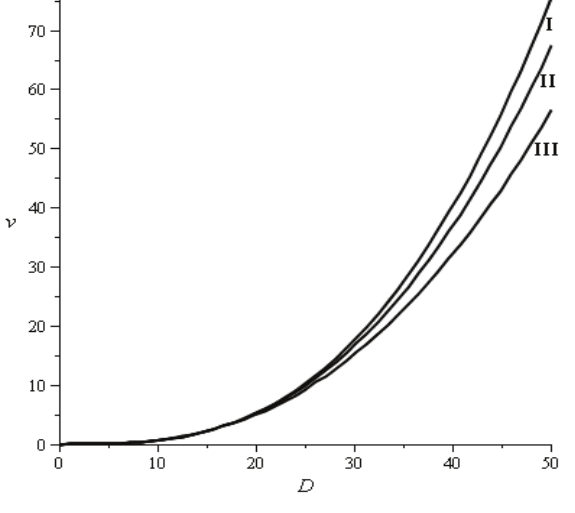
Figure 2. Stumpage price models: Quality I, v = D 3.186471 exp( (cid:28)202 (cid:14)34(cid:15)(cid:4)(cid:28)(cid:4)(cid:31)0(cid:26)2(cid:31)(cid:26)(cid:31)25(cid:30) D ); Quality II, v = D 3.114196 exp( (cid:28)20(cid:14)2(cid:26)4 (cid:26)(cid:4) (cid:28)(cid:4) 303 (cid:25)(cid:30)(cid:15)45(cid:30) v = D 2.987053 exp( (cid:28)20(cid:30)(cid:30) 322(cid:4) (cid:28)(cid:4) (cid:30)0 2(cid:31)24(cid:15)5(cid:30) diameter D in cm). The coefficient of determination was always greater than